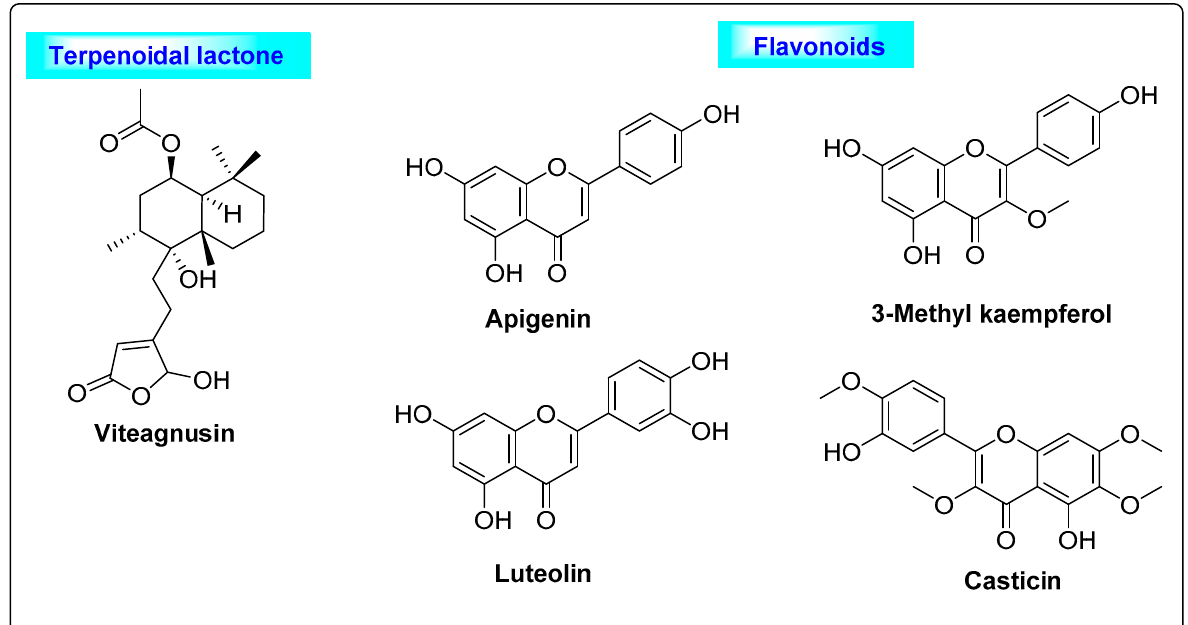
Figure 4. Terpenoidal lactone and flavonoids of Vitex agnus castus responsible for improving ovulatory cycle.